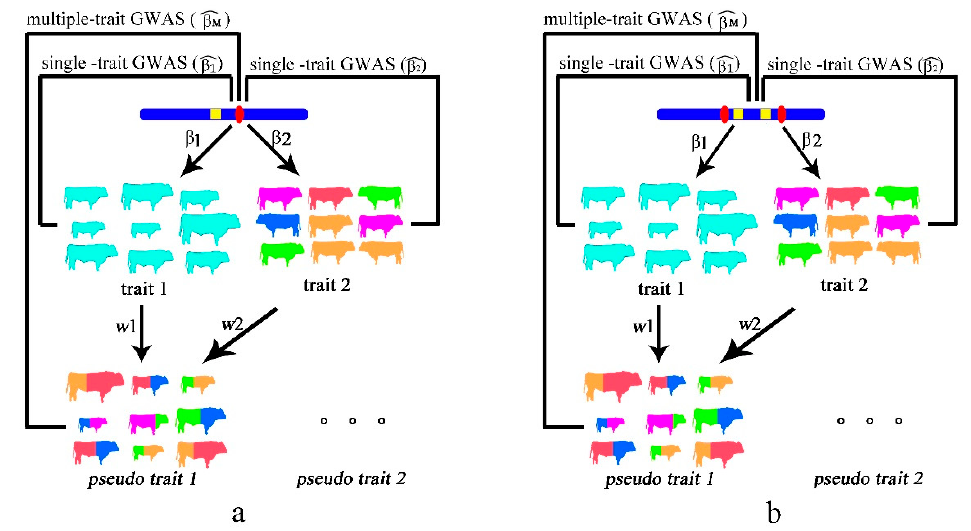
Figure 1. Layout of principal component analysis (PCA)-based multiple-trait genome-wide association studies (GWAS) versus single-trait GWAS. ( a ) Single causal variant model. Provided that a casual single nucleotide polymorphism (SNP) (red spot) has an effect on trait 1 (cattle size) and trait 2 (cattle color) with β 1 and β 2, the process of estimation of β 1 and β 2 using trait 1 and trait 2 is called single-trait GWAS. According to components decomposition, pseudo traits are formed and the process of estimation of β M is called PCA-based multiple-trait GWAS. The yellow marker represents genotyped SNP in beadchip. ( b ) Colocalizing effect model. Two different genetic variants in high linkage disequilibrium that affect different traits. In both situations, we compared the relationships among β 1, β 2, and β M .